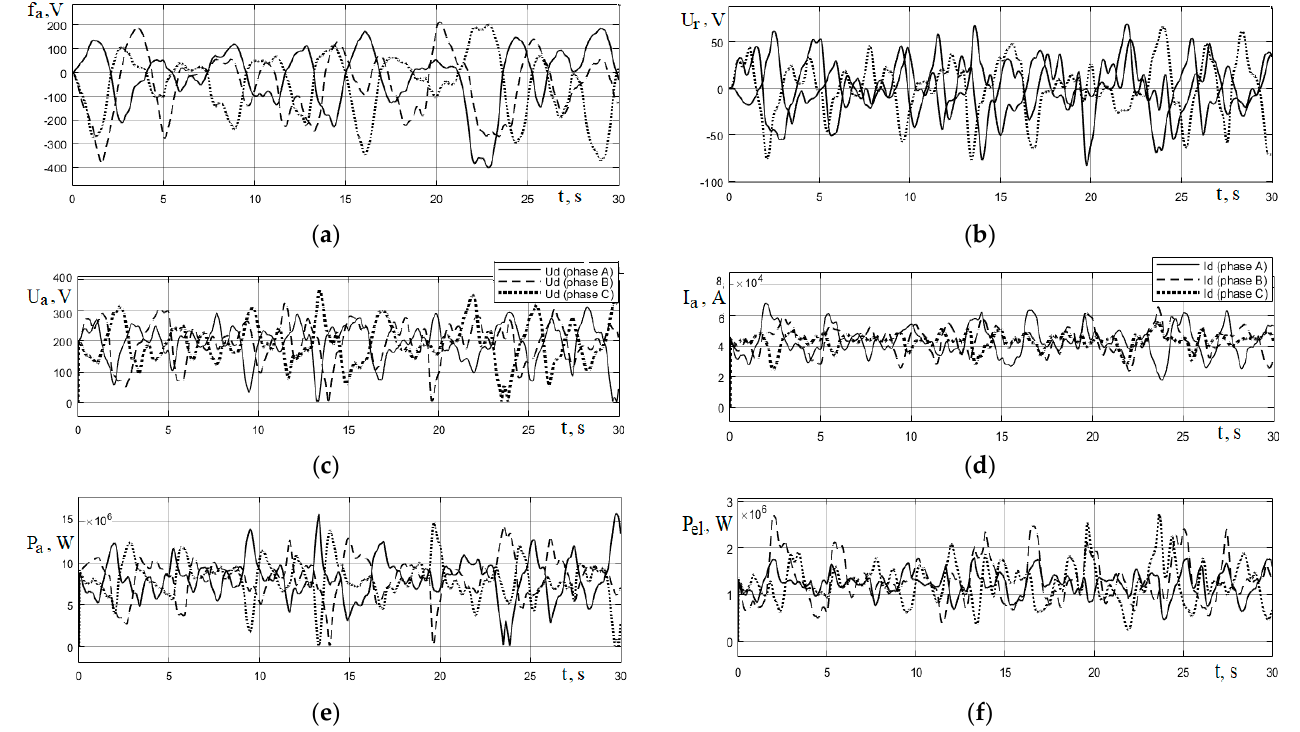
Figure 11. Time dependences of random perturbations: ( a ) mismatch signals; ( b , c ) voltages; ( d ) cur- rents; ( e ) power of arcs; ( f ) power of electric losses when using differential model (1) (ARDM-T-12) for energy-intensive regime of melting of wells in a solid charge.